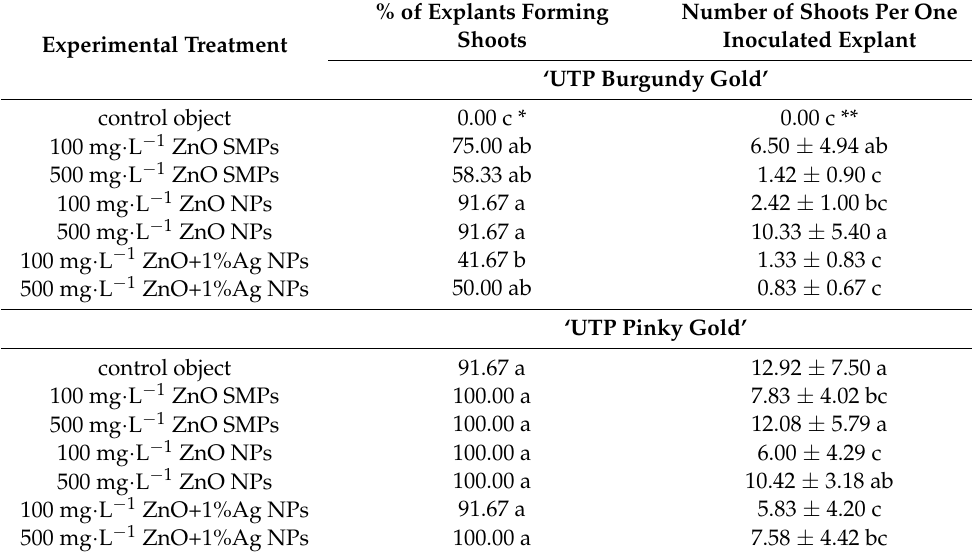
Table 3. Efficiency of adventitious shoots regeneration on Chrysanthemum × morifolium ‘UTP Bur- gundy Gold’ and ‘UTP Pinky Gold’ internodes cultured for 9 weeks on the modified MS medium with 0.6 mg · L − 1 BAP and 2 mg · L − 1 IAA, depending on the experimental treatment. % of Explants Forming Number of Shoots Per One Shoots Inoculated Explant Experimental Treatment ‘UTP Burgundy Gold’ control